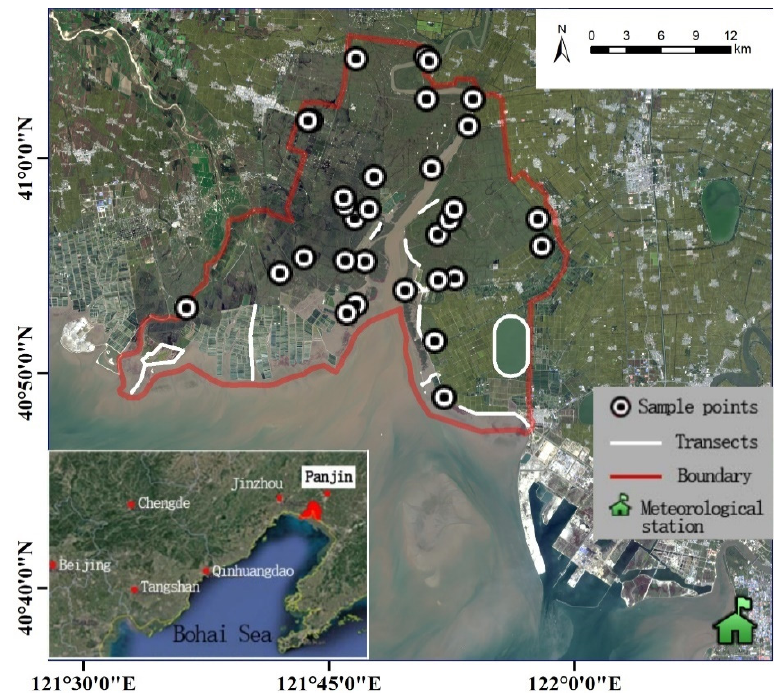
Figure 1. Study area (inside the red border).